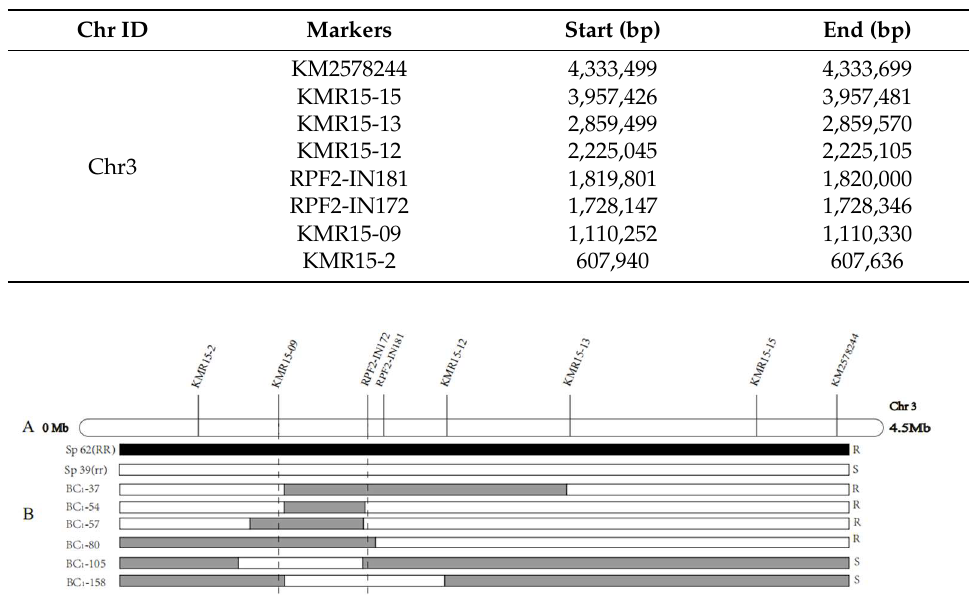
Table 2. The position of RPF2 markers on the genome.